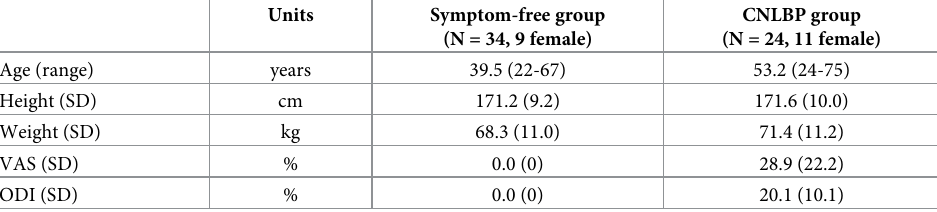
Table 1. Mean and range values for characteristics of the study